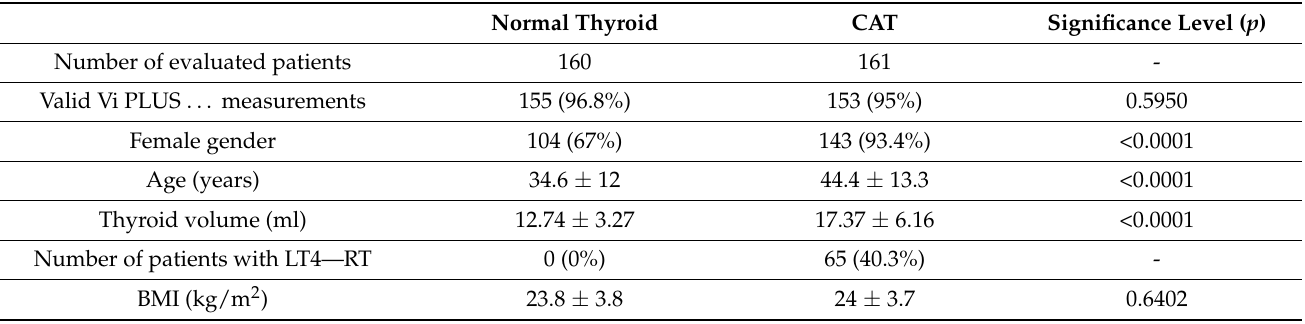
Table 1. Baseline characteristics for the patients with and without CAT. Normal Thyroid CAT Significance Level ( p ) Number of evaluated patients